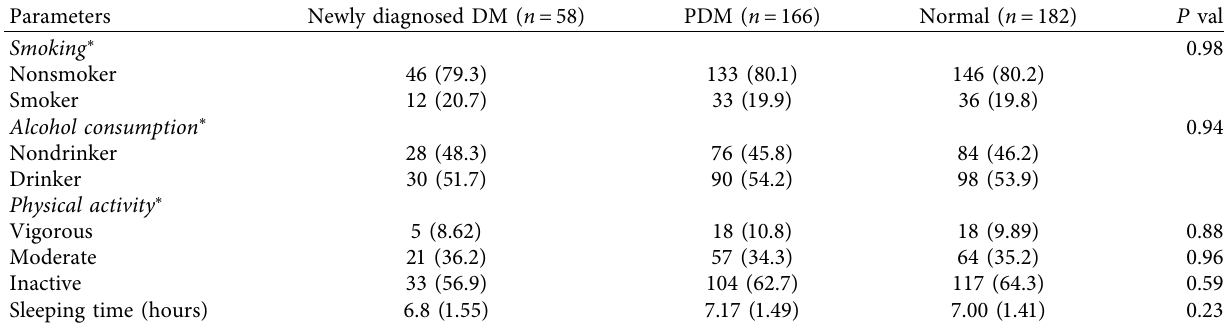
Table 4: Baseline behavioral characteristics of study participants.